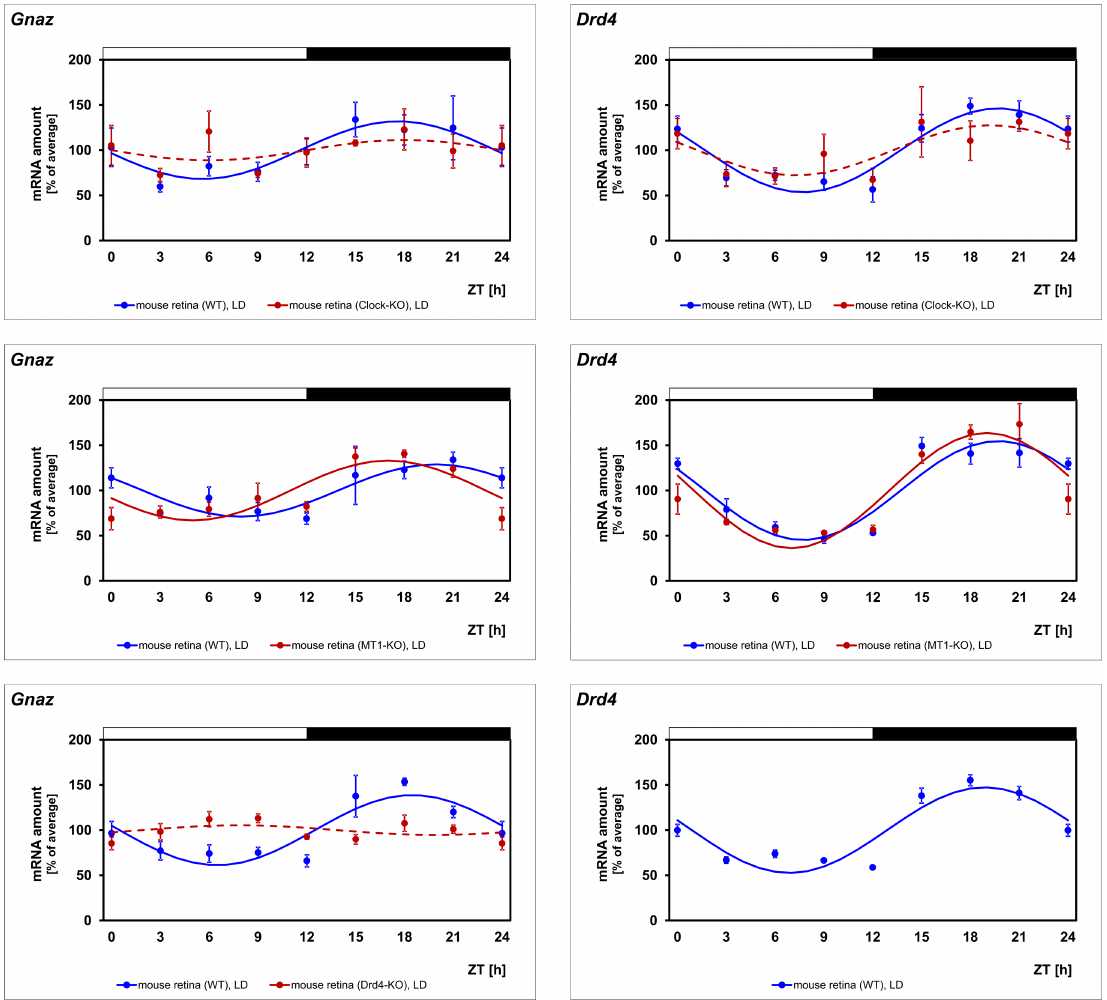
Fig 5. Daily profiling of Gnaz mRNA in mice deficient for Clock , MT1 or Drd4 . Transcript levels of Gnaz and Drd4 were recordedin WT mice (blue lines) versus mice deficient(red lines) for Clock (first row), melatoninreceptor type 1 (secondrow) or dopamine D 4 receptor (third row) in preparations of the wholeretina under LD using qPCR. The mRNA levels are plotted as a function of ZT. The lines represent the periodicsinusoidal functions determinedby cosinor analysis(solid and brokenline for p < 0.05 and p > 0.05). Data represent a percentageof the averagevalue of the transcript amount duringthe 24-h period. Statistical analysisof transcriptional profilingis providedin Table 2. Note that expressionof Gnaz is arrhythmic in mice deficient for Clock or dopamine D 4 receptors and tends to be phase-advanced in mice deficientfor MT1 . The value of ZT0 is plotted twice at both ZT0 and ZT24. The solid bars indicate the dark period.Each value represents mean ± SEM (n = 4; each n represents one animal (two retinae)). Drd4 mRNA was not detectablein Drd4